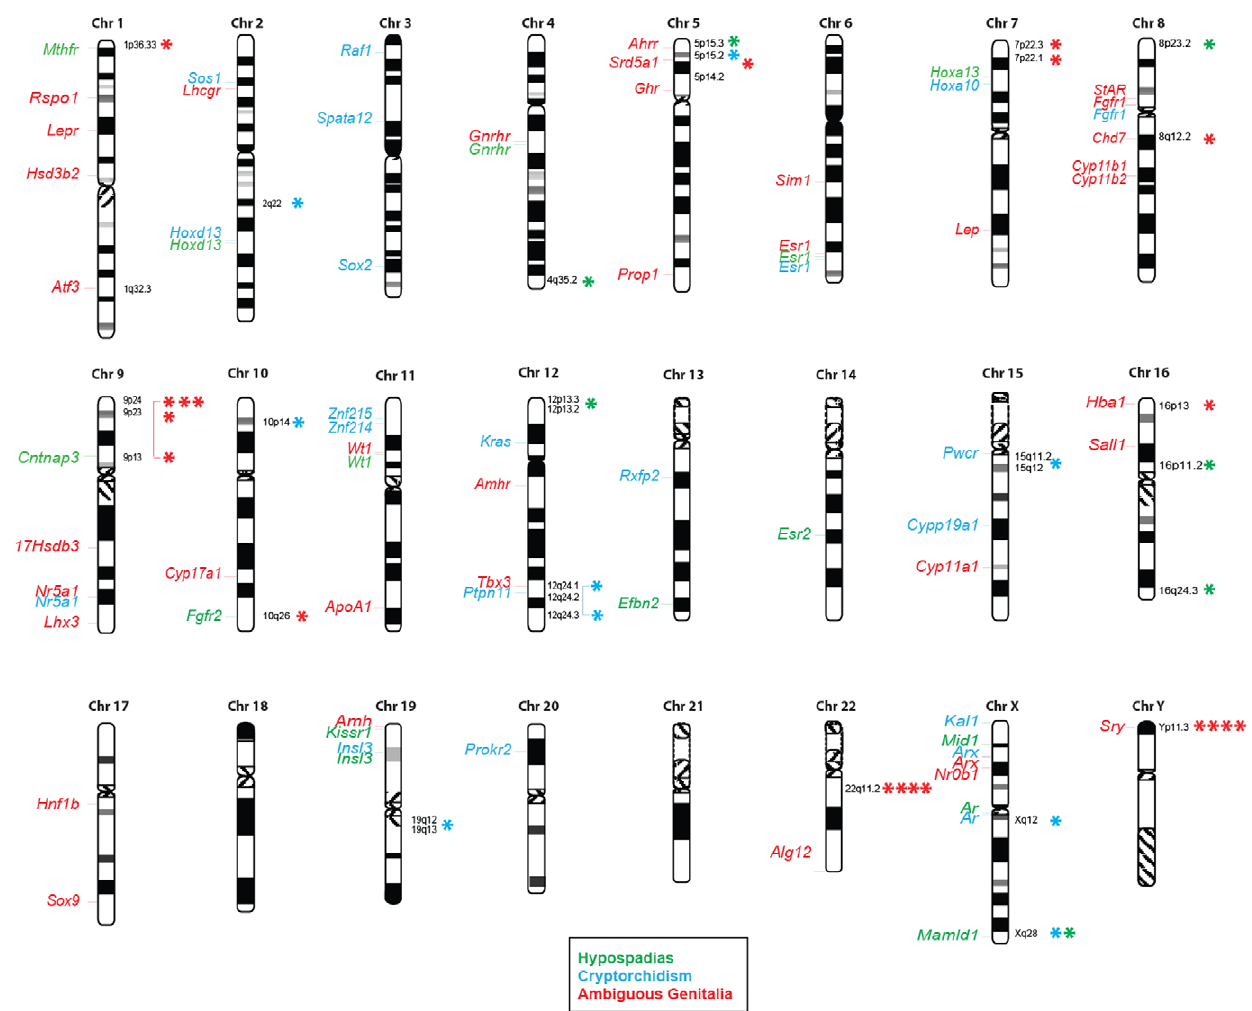
Figure 1. Comprehensive map of non-polymorphic copy number changes detected by CMA in patients with disorders of sex development. On the right, CMA detected imbalances were shown for each clinical condition (asterisks). To gain insight into the genomic distribution of the identified imbalances, all published single gene mutations associated with cryptorchidism (blue), hypospadias (green) and ambiguous genitalia (red) were reviewed and indicated on the left side of the chromosomes. References are available upon request.